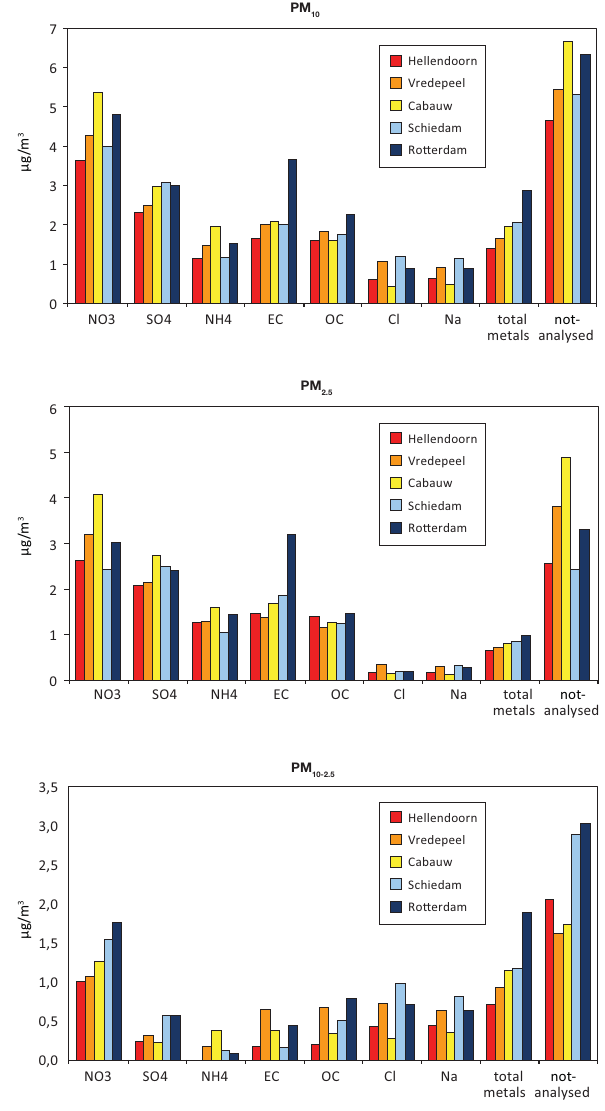
Fig. 2. Absolute concentrations at the five